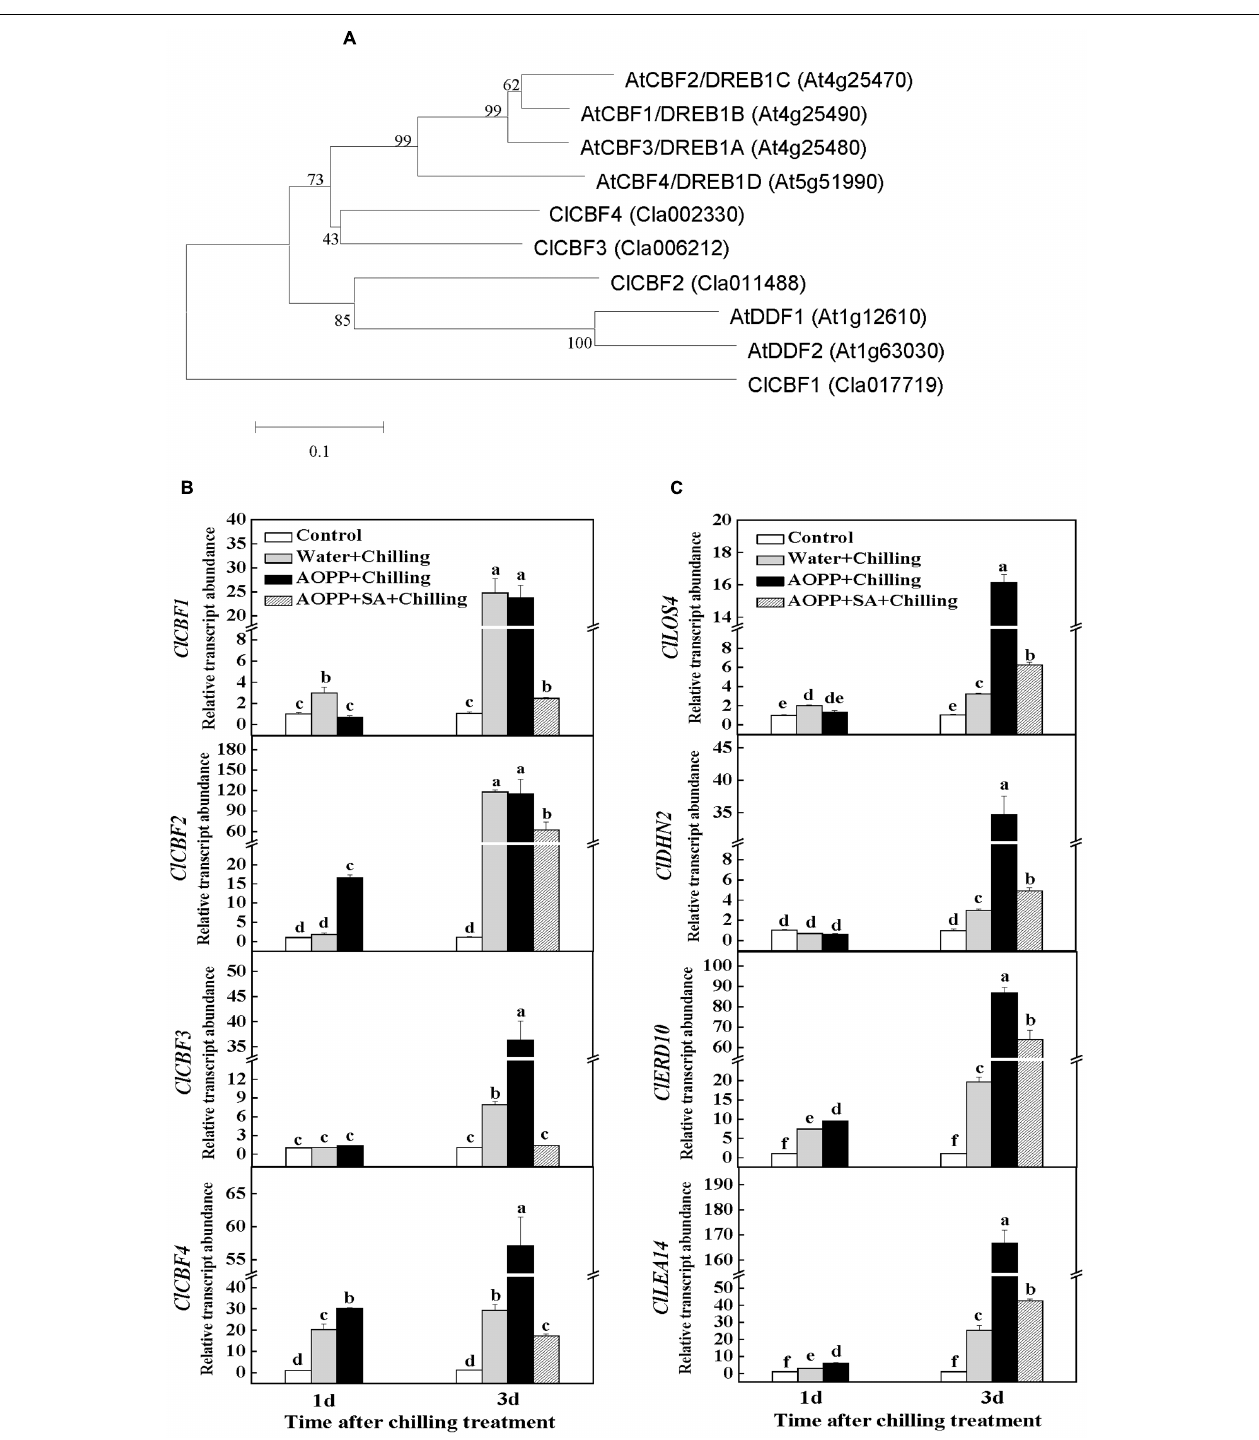
FIGURE 8 | The effects of chilling and SA on the expression of CBF and cold-responsive ( COR ) genes in watermelon plants. (A) Phylogenetic tree of CBFs from Citrullus lanatus (Cl) and those identified DREB1/CBF proteins from Arabidopsis . The phylogenetic tree was constructed using MEGA 5 with the Neighbor–Joining method. Bootstrap values calculated from 1000 trials are shown at each node. The extent of divergence according to the scale (relative units) is indicated at the bottom. Predicted mature polypeptides lacking the putative transit peptide were employed for tree construction. (B) Changes in the expression of CBF genes in watermelon. (C) Changes in the expression of COR genes in watermelon. Leaf samples were collected at the indicated times. The data are the means of four replicates with SEs. Different letters indicate significant differences between the treatments according to Tukey’s test ( P < 0.05).